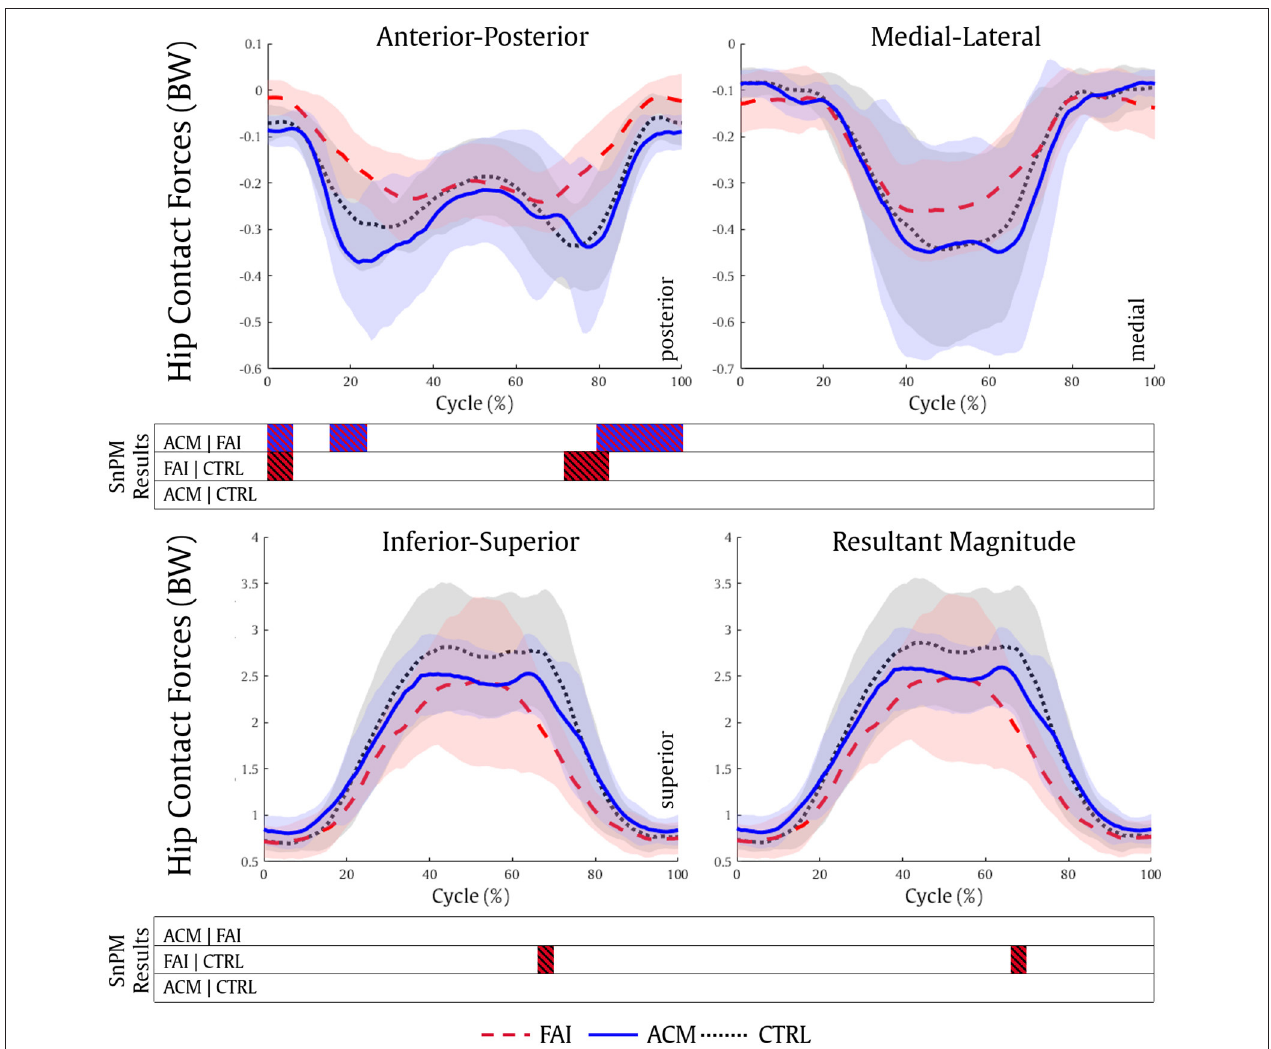
FIGURE 4 | Hip contact forces during the squatting task for the FAI (dashed red), ACM (solid blue), and CTRL (dotted black) groups. SnPM results are displayed below the figure and indicate significant differences among the groups ( P ≤ 0.016). SnPM, statistical non-parametric mapping; BW, body weight; FAI, femoroacetabular impingement; ACM, asymptomatic cam morphology; CTRL, control. Shading indicates standard